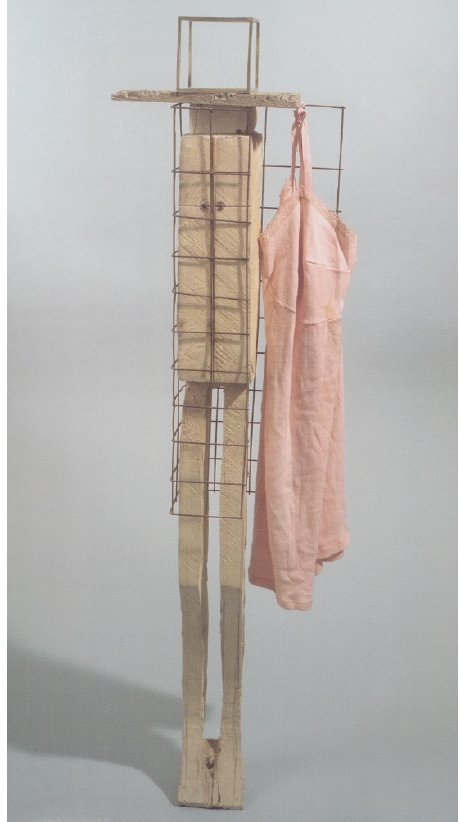
Figure 8. Leon Podsiadły, Halka [ The Slip ], 2012, metal, wood, fabric. Photograph by Stanisław Sielicki. After: (Wąs 2012a, p. 101). Photo used with the permission of the artist’s family.